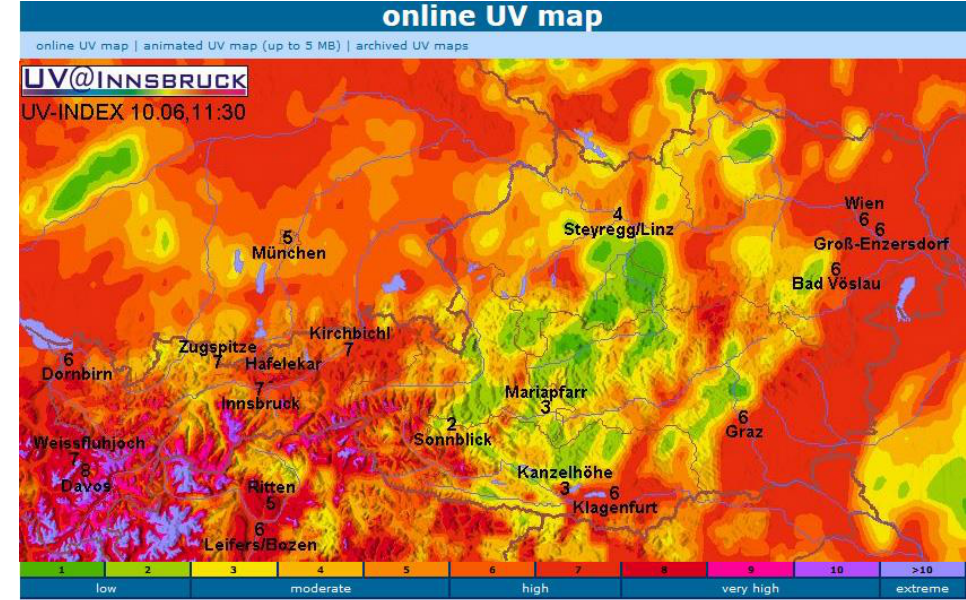
Figure 3. Map of the regional distribution of the UVI over Austria on 10 June 2018 at 11:30 local time. The locations of the measurement stations are marked with their measured UVI. In the south-east of the map the weather is clear, so that the UVI is dominated by the local topography. In the north-east, middle, and south-west, thick clouds reduce the UVI significantly.